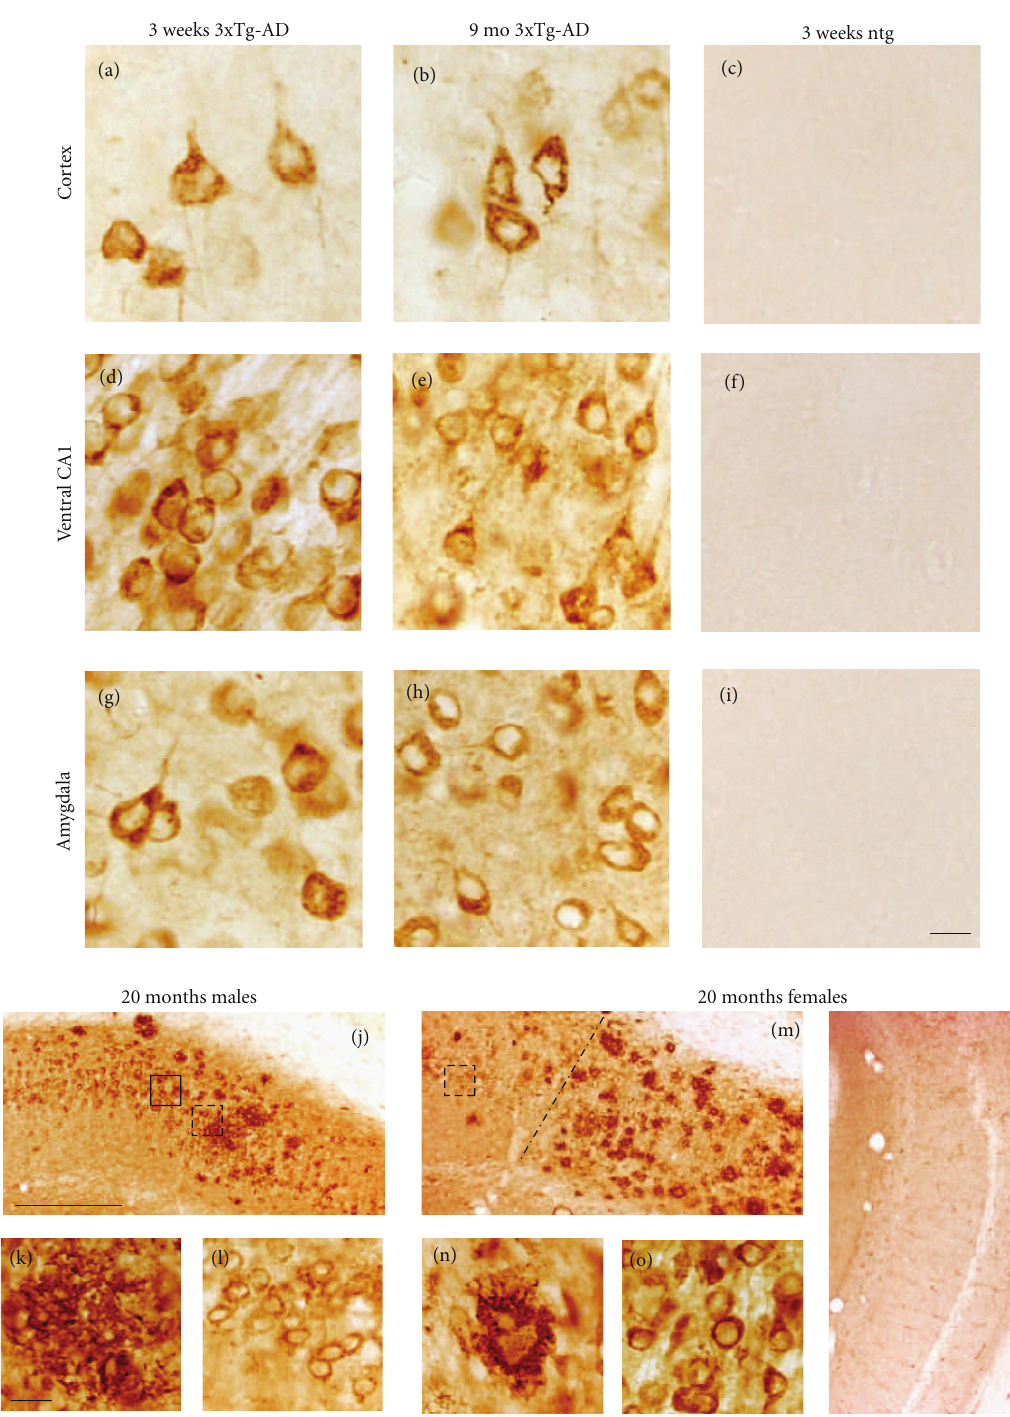
Figure 3: Photomicrographs showing 6E10 intraneuronal immnostaining in the cortex ((a)–(c)), ventral CA1 ((d)–(f)), BLA ((g)–(i)), and subiculum ((j)–(o)) in 3-week, 9- and 20-month-old 3xTg-AD mice. Round-or oval-shaped 6E10-ir neurons were found at the youngest age in all brain regions examined independent of fixation ((a), (d), (g)). At 9 months some 6E10 stained neurons appeared shrunken with a hollow center ((b), (e), (h)). 6E10 immunopositive plaques were found throughout the subiculum of female (j), and to a lesser extent in male mutant mice (m) at 20 months of age. Solid and dashed boxed areas in panels (j) and (m) outline a 6E10-ir plaque (k) and CA1-ir neurons shown at higher magnification in (l) and (o), respectively. Dashed line in panel m demarks the CA1 field from the subiculum. Higher-power photomicorgraph shows a posterior subicular 6E10 positive plaque in a female 20-month-old mutant mouse (n). Tissue processed following 6E10 antibody peptide preadsorbtion shows a lack of intra-or extraneuronal staining in CA1 or subiculum (P). Note the more di ff use compared to the compact nature of plaques found in male-versus female-aged mutant mice. Ntg mice failed to display 6E10 immunoreactivity (c, f, i) at 3 weeks of age. Scale bar in ((a)–(i)); ((k), ((l), (n), (o)) = 20 μ m, ((j), (m)) = 100 μ